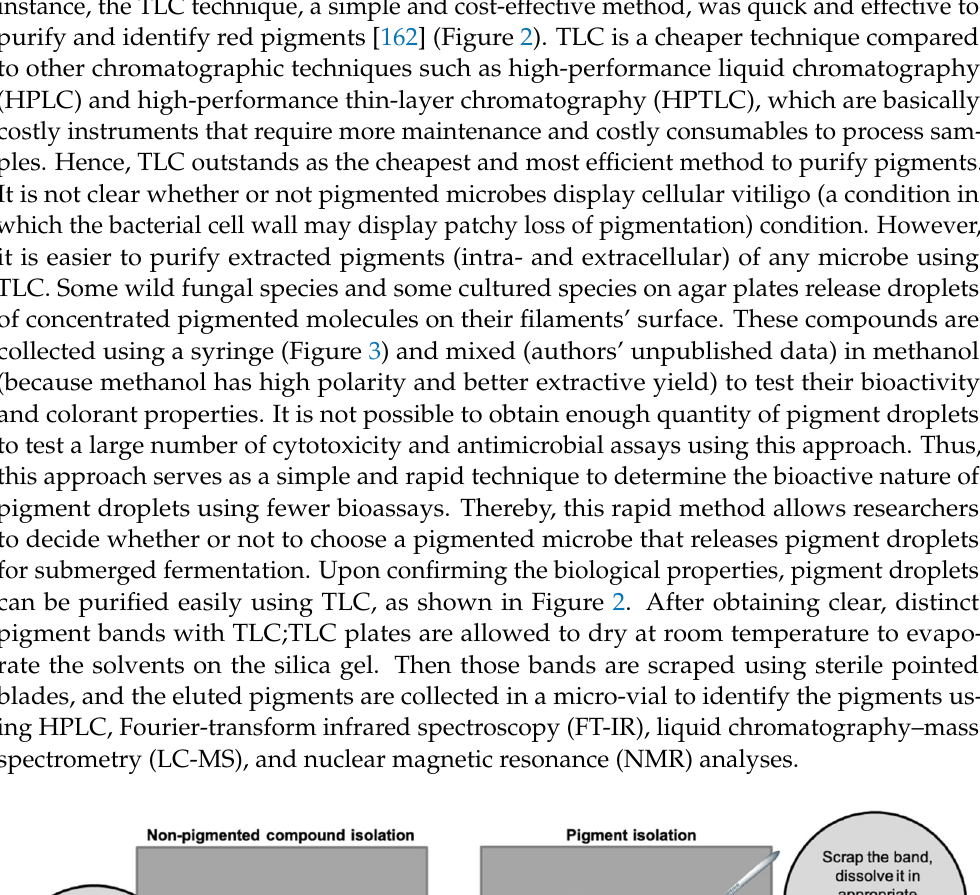
Figure 3. Isolation of concentrated pigment droplets (authors’ unpublished data) released by fungi on their mycelia surfaces and testing them directly for biological properties in a simple and rapid